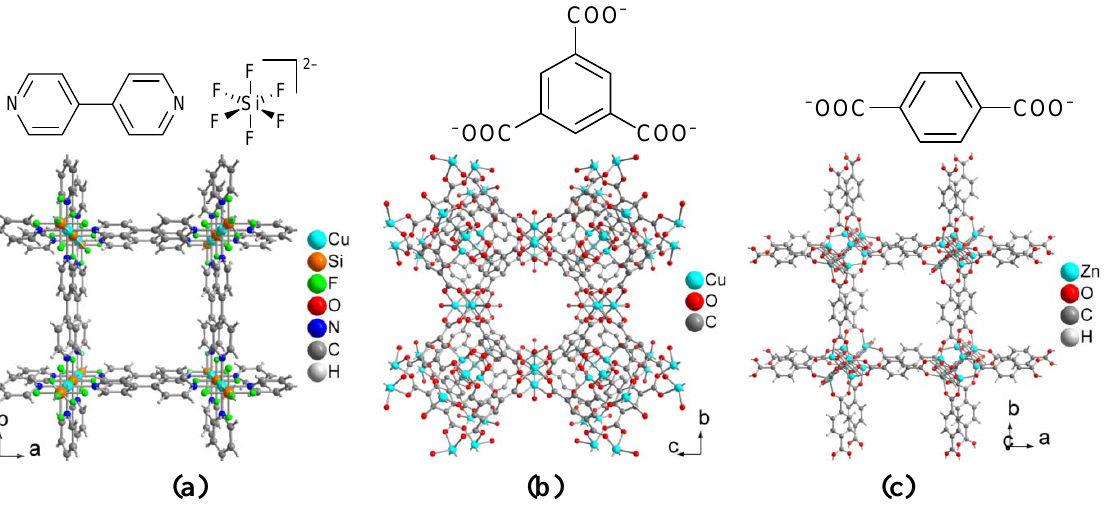
Figure 11. Linkers and sections of the packing diagrams of ( a ) Cu-BPY-HFS, [Cu(µ-SiF )(µ-4,4'-bipy) ] (BPY = 4,4'-bipyridine, HFS = hexafluorosilicate), ( b ) Cu-BTC 6 2